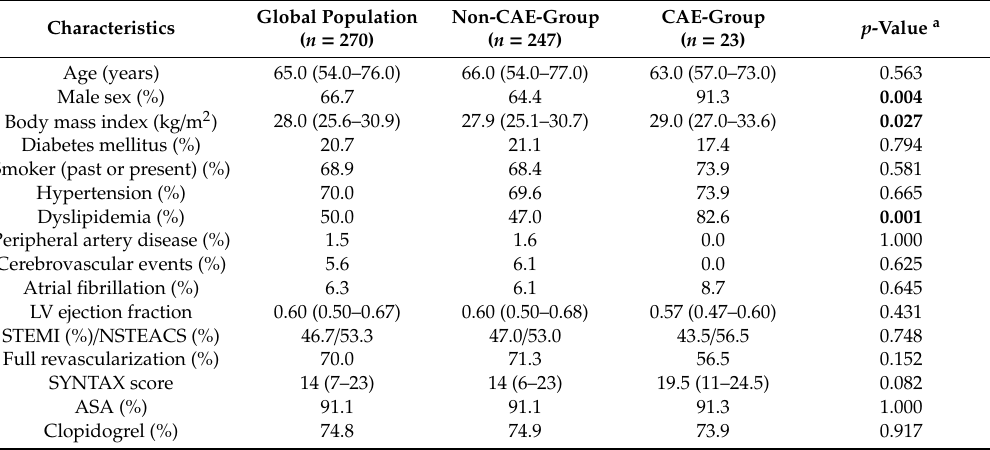
Table 1. Clinical